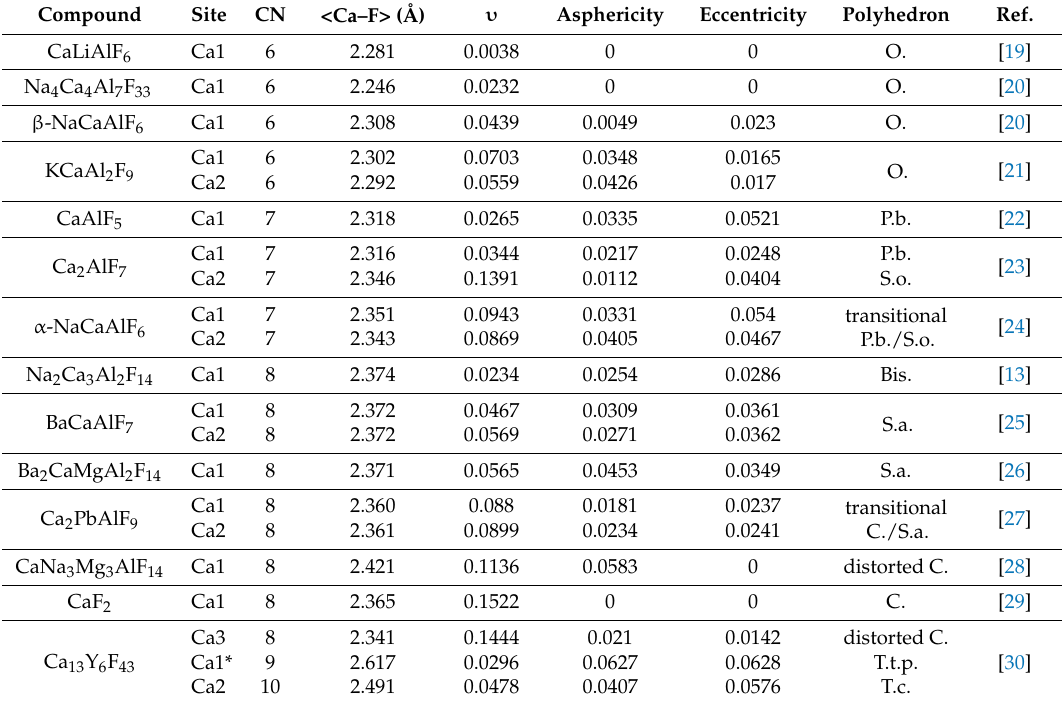
Table 3. The coordination parameters of [CaF n ] coordination polyhedra in fluoride minerals and related synthetic compounds; υ = volume distortion; O. = Octahedron; P.b. = Pentagonal bipyramid; S.o. = Split octahedron; Bis. = Bisdisphenoid; S.a. = Square antiprism; C. = Cube; T.t.p. = Tricapped trigonal prism; T.c. = Tricapped